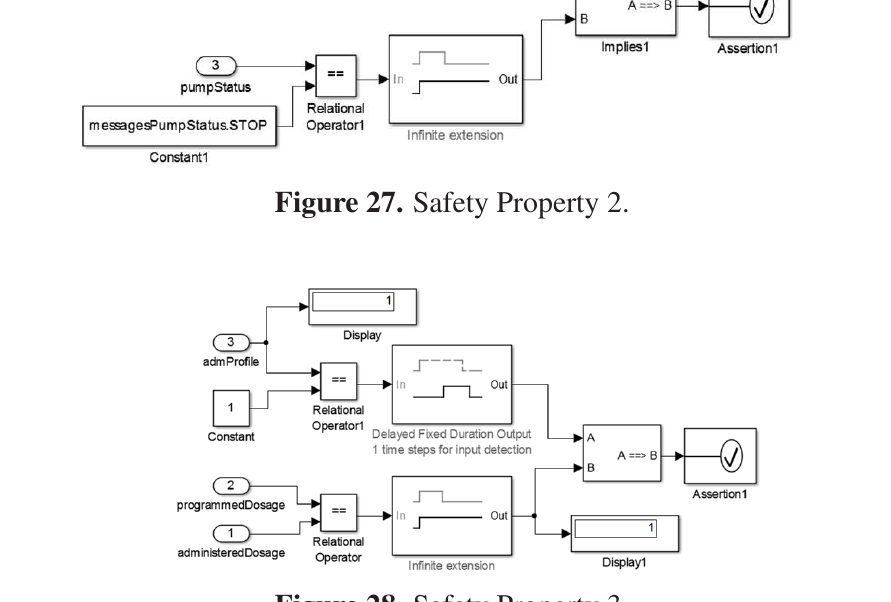
Figure 28. Safety Property 3.